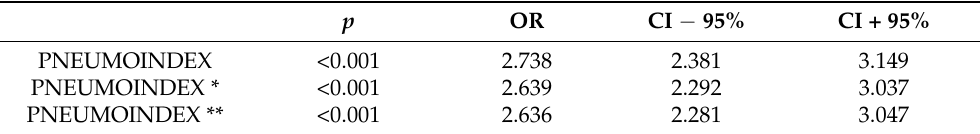
Table 7. Multivariate logistic regression for pneumonia using